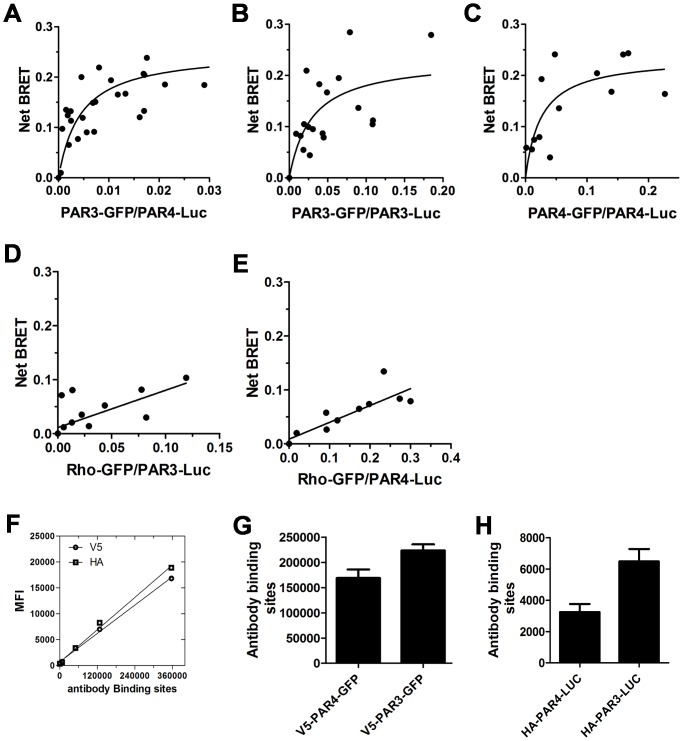
Bioluminescence resonance energy transfer (BRET) analysis of PAR3 homodimers, PAR4 homodimers, and PAR3-PAR4 heterodimers.The HEK293 cells were transfected with: (A) PAR4-Luc (1 µg) and PAR3-GFP (0–2.5 µg), (B) PAR3-Luc (1 µg) and PAR3-GFP (0–2.5 µg), or (C) PAR4-Luc (1 µg) and PAR4-GFP (0–2.5 µg). As a control experiment, the HEK293 cells were transfected with: (D) PAR3-Luc (1 µg) and rho-GFP (0–0.12 µg), or (E) PAR4-Luc (1 µg) and rho-GFP (0–0.12 µg). Forty-eight hours post-transfection, the cells were analyzed for GFP expression, Luc expression, and BRET. The curves were plotted as the ratio of GFP to Luc and all points from 3–6 independent experiments were analyzed by global fit to a hyperbolic or linear curve. The surface expression of PAR3 and PAR4 in the HEK293 cells was determined by flow cytometry. (G) V5-PAR4-GFP and V5-PAR3-GFP were detected with a V5 tag antibody conjugated to Alexa Fluor 647. (H) HA-PAR4-LUC and HA-PAR3-LUC were detected with a HA tag antibody conjugated to Alexa Fluor 647. The results are the mean (± SD) of two independent experiments. The number of PAR4 and PAR3 molecules on the HEK293 cells surface is calculated from the V5 or HA antibody standard curve using quantitative flow cytometry (F).